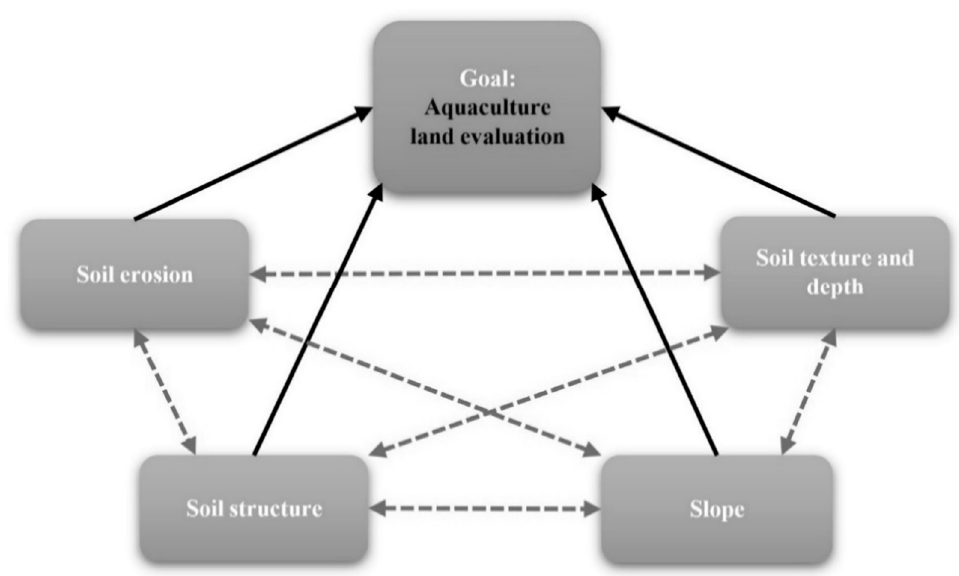
Figure 4. Conceptual model of aquaculture land evaluation in Markazi province.